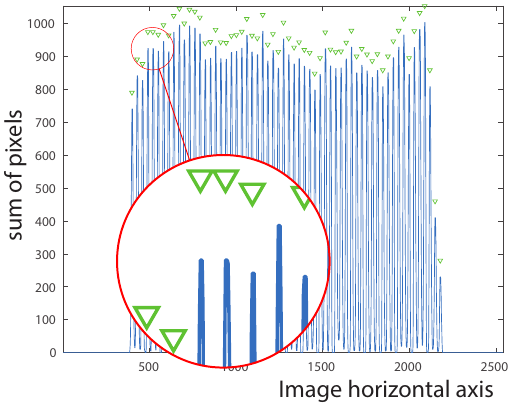
Figure 8. Original signal where overlapping peaks may occur.